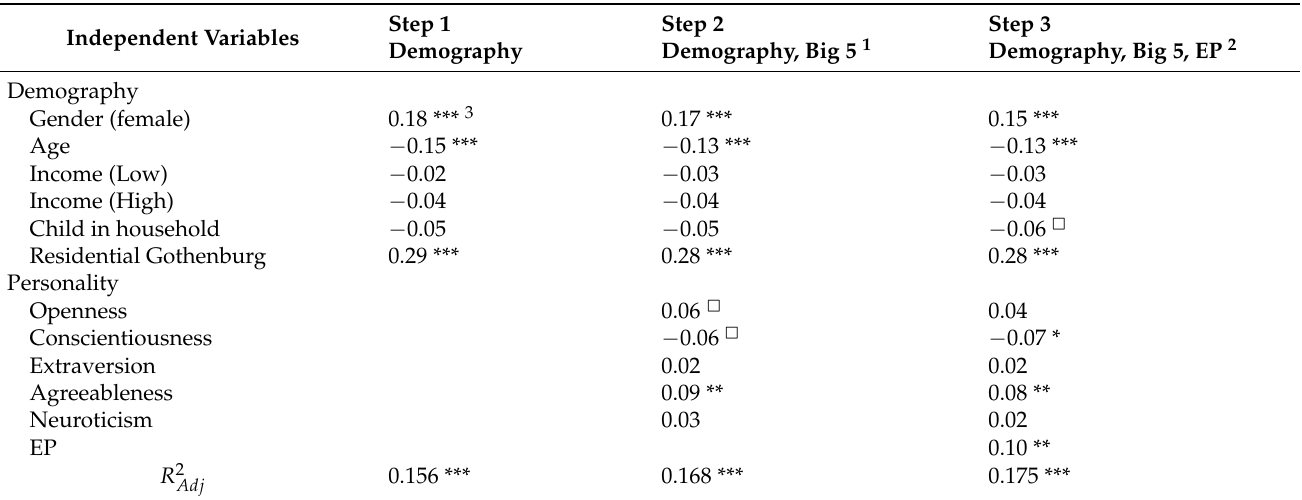
Table 4. Hierarchical regression models exploring how personality predict use of public transporta- tion ( N = 959).